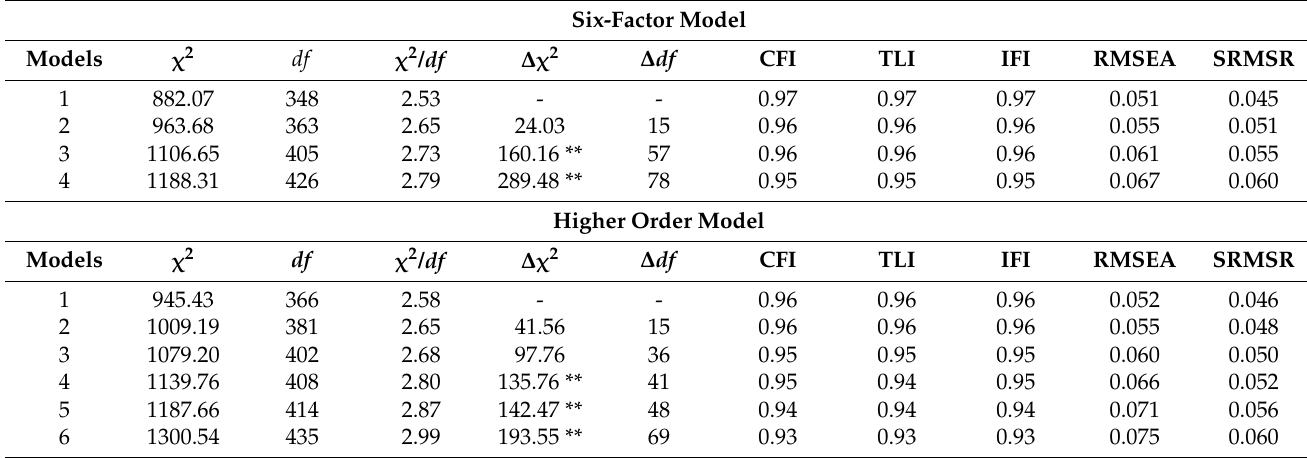
Table 3. Analysis of invariance by sex.